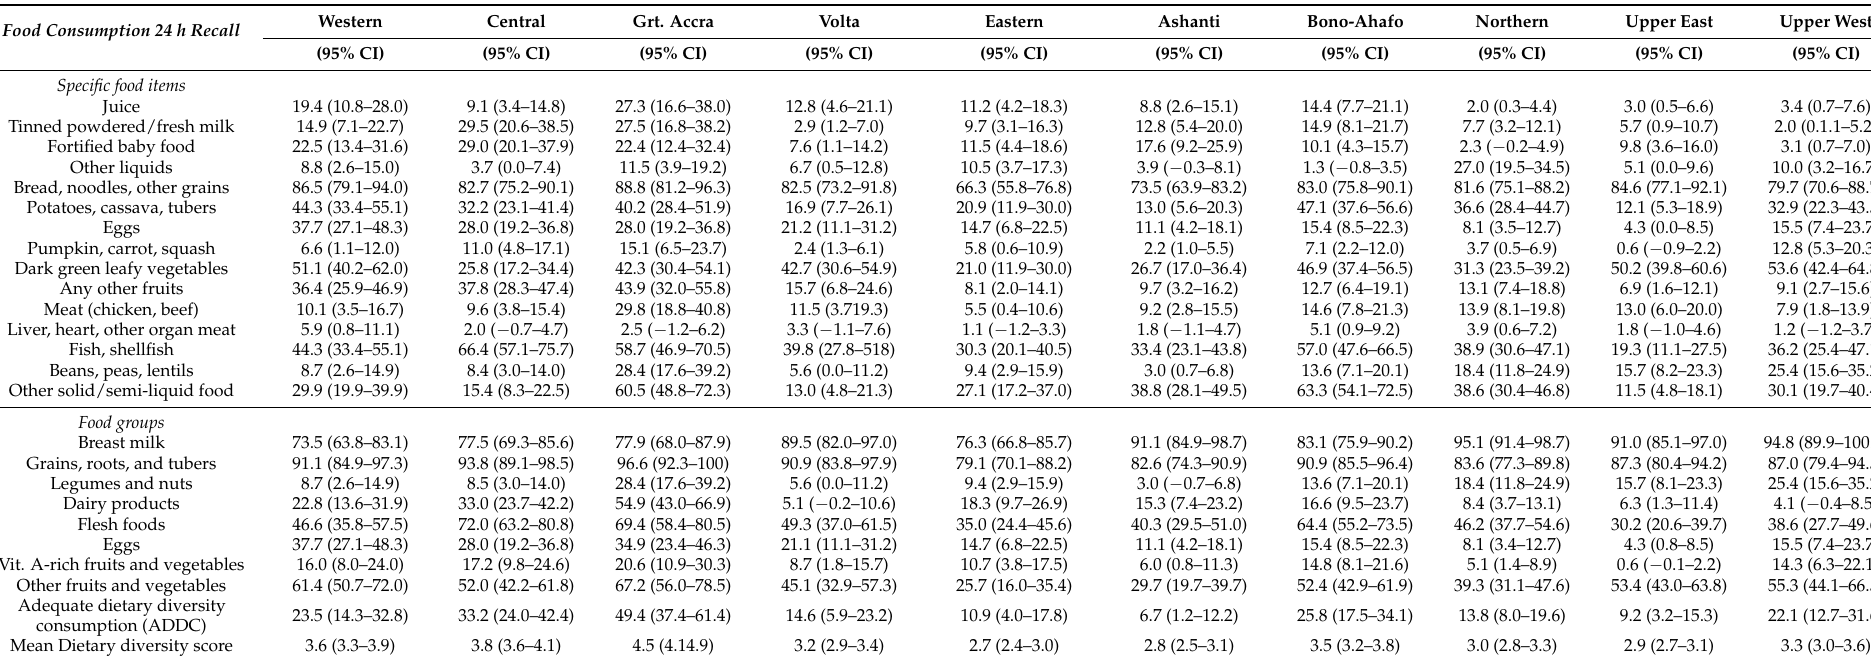
Table 5. 24 h recall of consumption of food items, food groups, and dietary diversity by geographical area of children aged 6–23 months, mean values (%) with confidence intervals (CIs),